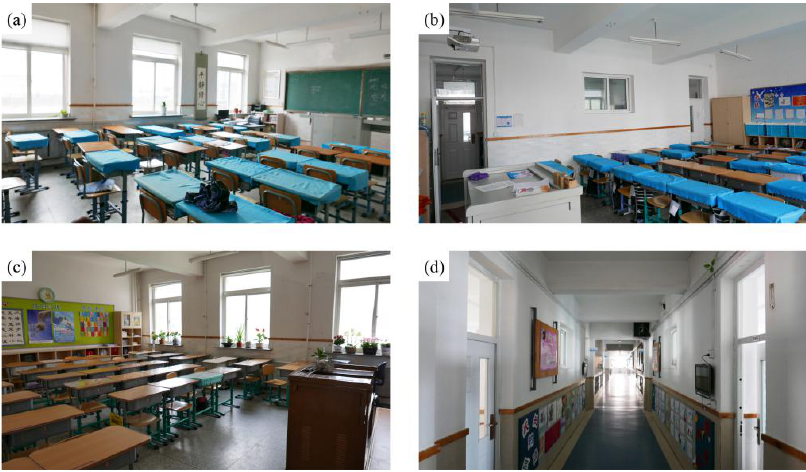
Figure 4. Selected classrooms for measurements: ( a ) S1; ( b ) S2; ( c ) N1; ( d ) The corridor in the 4th floor.